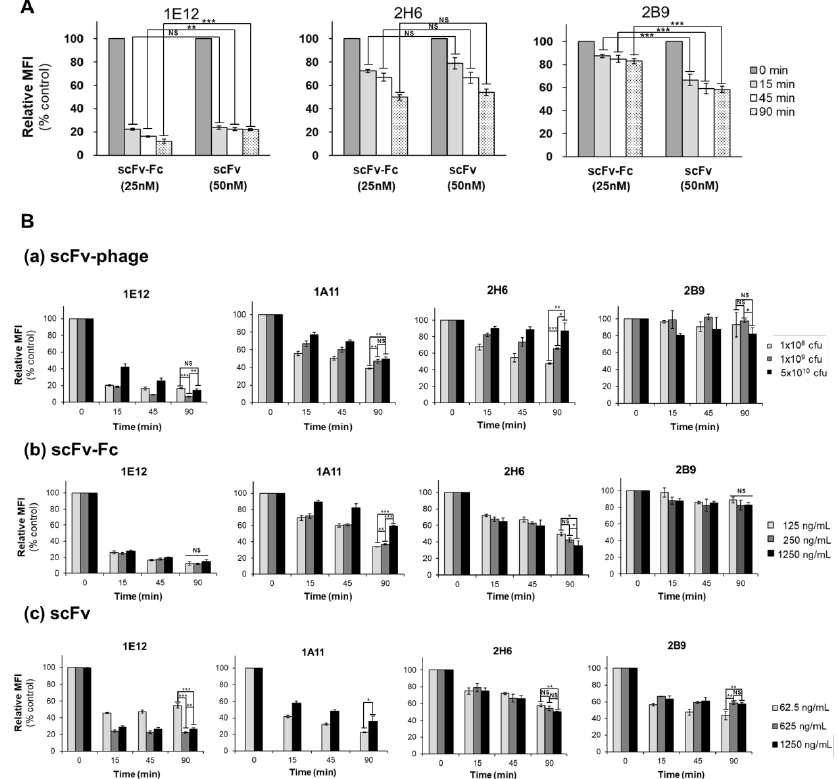
Figure 5. Effect of stoichiometric molar ratio and concentration of antibody fragments on internalization. ( A ) Comparison of bivalent scFv-Fc and monovalent scFv internalization into MDA-MB-453. 1E12, 2H6 and 2B9 antibody internalization were analyzed at the indicated times by flow-based internalization assay. Bivalent scFv-Fc and monovalent scFv were used at the final concentration of 25nM and 50nM (1:1 stoichiometry for antigen–antibody interaction), respectively. ( B ) Effect of concentration on internalization of ( a ) scFv-phage (1 × 10 8 , 1 × 10 9 and 5 × 10 10 cfu), ( b ) scFv-Fc (125~1250 ng / mL) and ( c ) scFv (62.5~1250 ng / mL) into MDA-MB-453. Values represent geometric mean ± SD in triplicate. See supplemental Figure S5 for the representative histograms for the panel of antibodies from the experiments. Significance of mean comparison is annotated as follow; p > 0.05 (NS; non-significant), * p ≤ 0.05, ** p ≤ 0.01, *** p ≤